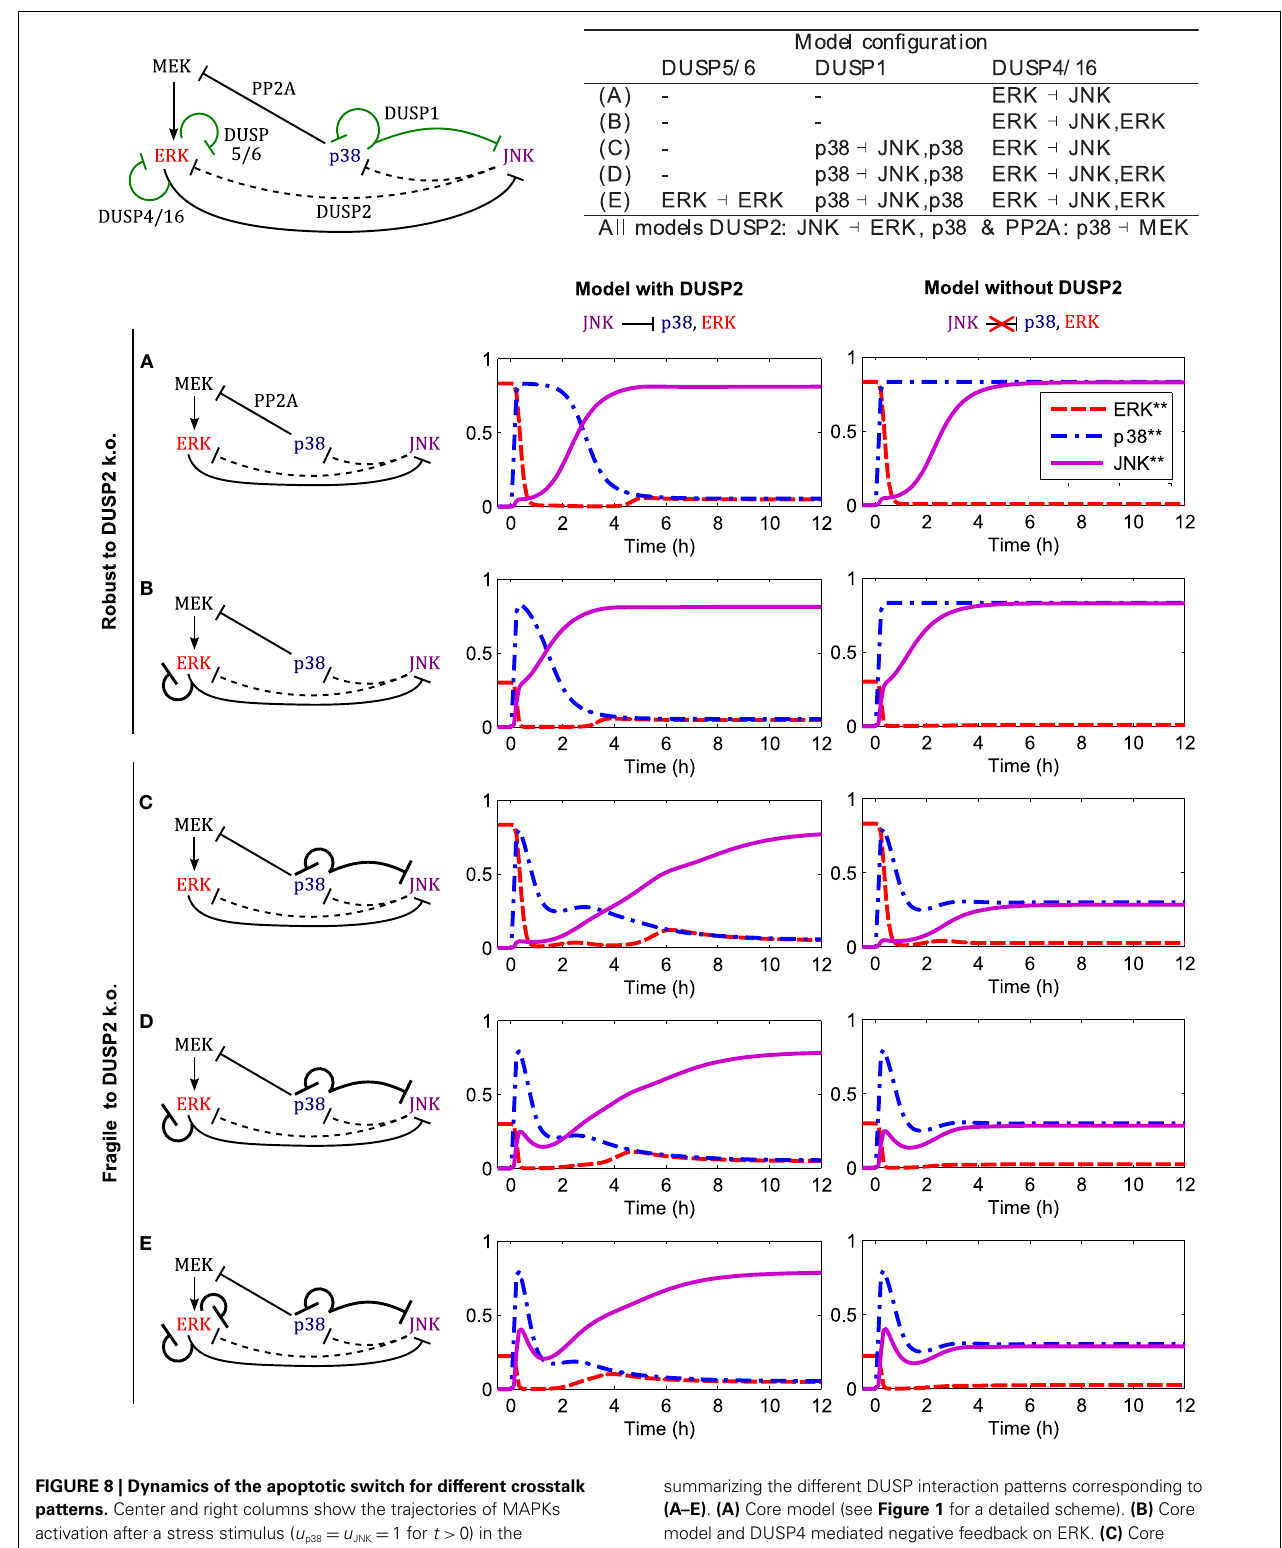
FIGURE 8 | Dynamics of the apoptotic switch for different crosstalk patterns. Center and right columns show the trajectories of MAPKs activation after a stress stimulus ( u p38 = u JNK = 1 for t > 0) in the presence of a mitotic signal ( u ERK = 1 for all t ) for the indicated interaction patterns.Top left: scheme of MAPK interactions. Black arcs indicate core interactions, green arcs indicate additional DUSP mediated interactions analyzed in panels (A–E) .Top right: table